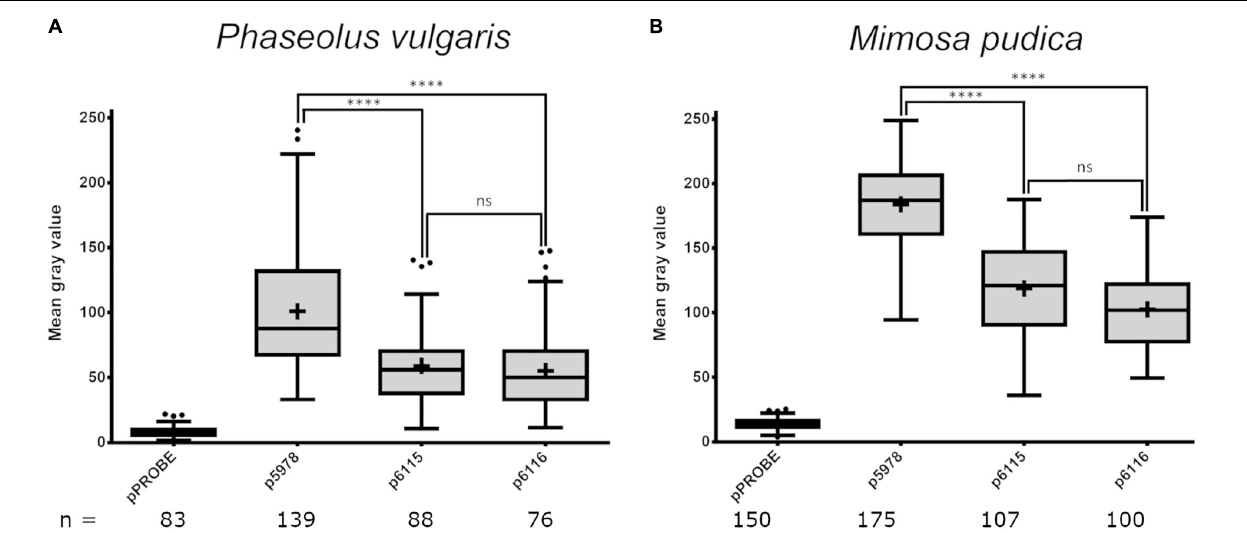
FIGURE 5 | Expression of P. phymatum wild-type GFP reporter constructs (pPROBE, p5978, p6115, and p6116) in nodules of Phaseolus vulgaris (A) and Mimosa pudica (B) . The pPROBE was used as negative control. Images were acquired with a confocal laser scanning microscope (DM5500Q; Leica) and single cells specific fluorescence quantified with Fiji. Plus signs indicate the arithmetic mean, whiskers minimum to maximum values and black dots outliers according to Tukey’s test. Significant differences between samples were analyzed in a one-way ANOVA with Tukey’s post hoc test ( ∗∗∗∗ p -value < 0.0001, ns, not significant). All T6SS reporter constructs values were found statistically different from pPROBE values.